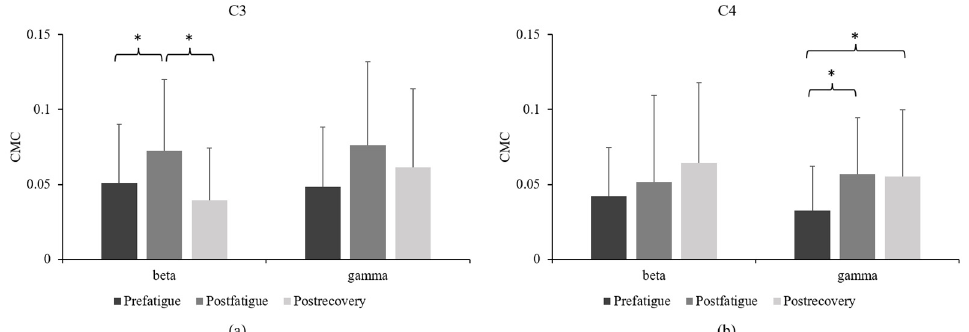
Figure 5. Comparison of ( a ) C3 corticomuscular coherence and ( b ) C4 corticomuscular coherence among the prefatigue, postfatigue, and postrecovery states. (* p < 0.05).